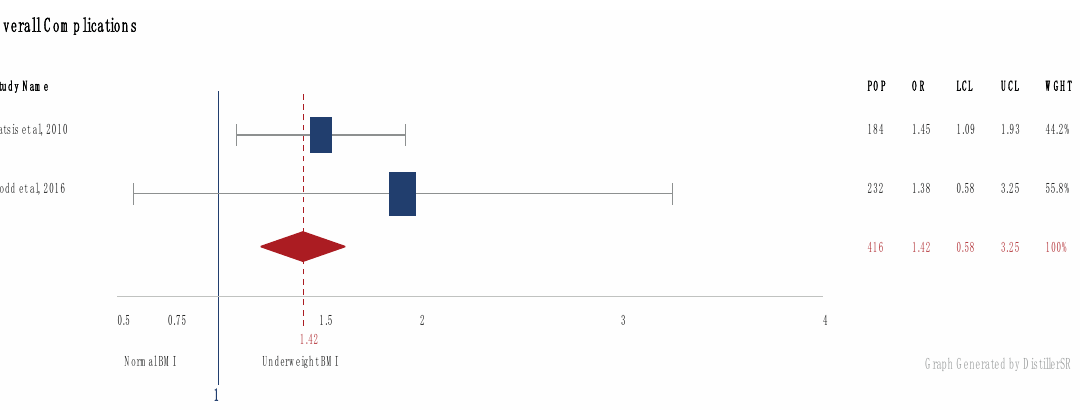
Figure 4. Forest plot comparing Odds Ratio (OR) for infections in the obese. (Number of patients (POP), Odds Ratio (OR), Upper (UCL) and Lower (LCL) Confidence interval and Weight (WGHT). Square reflects the number of patients and the diamond represents the total effect.